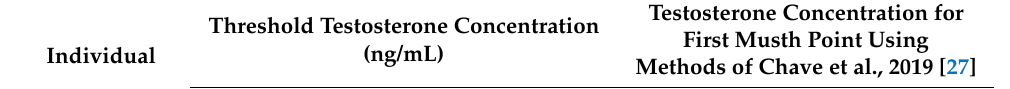
Table 7. Serum testosterone concentrations (ng/mL) corresponding to the beginning and end of